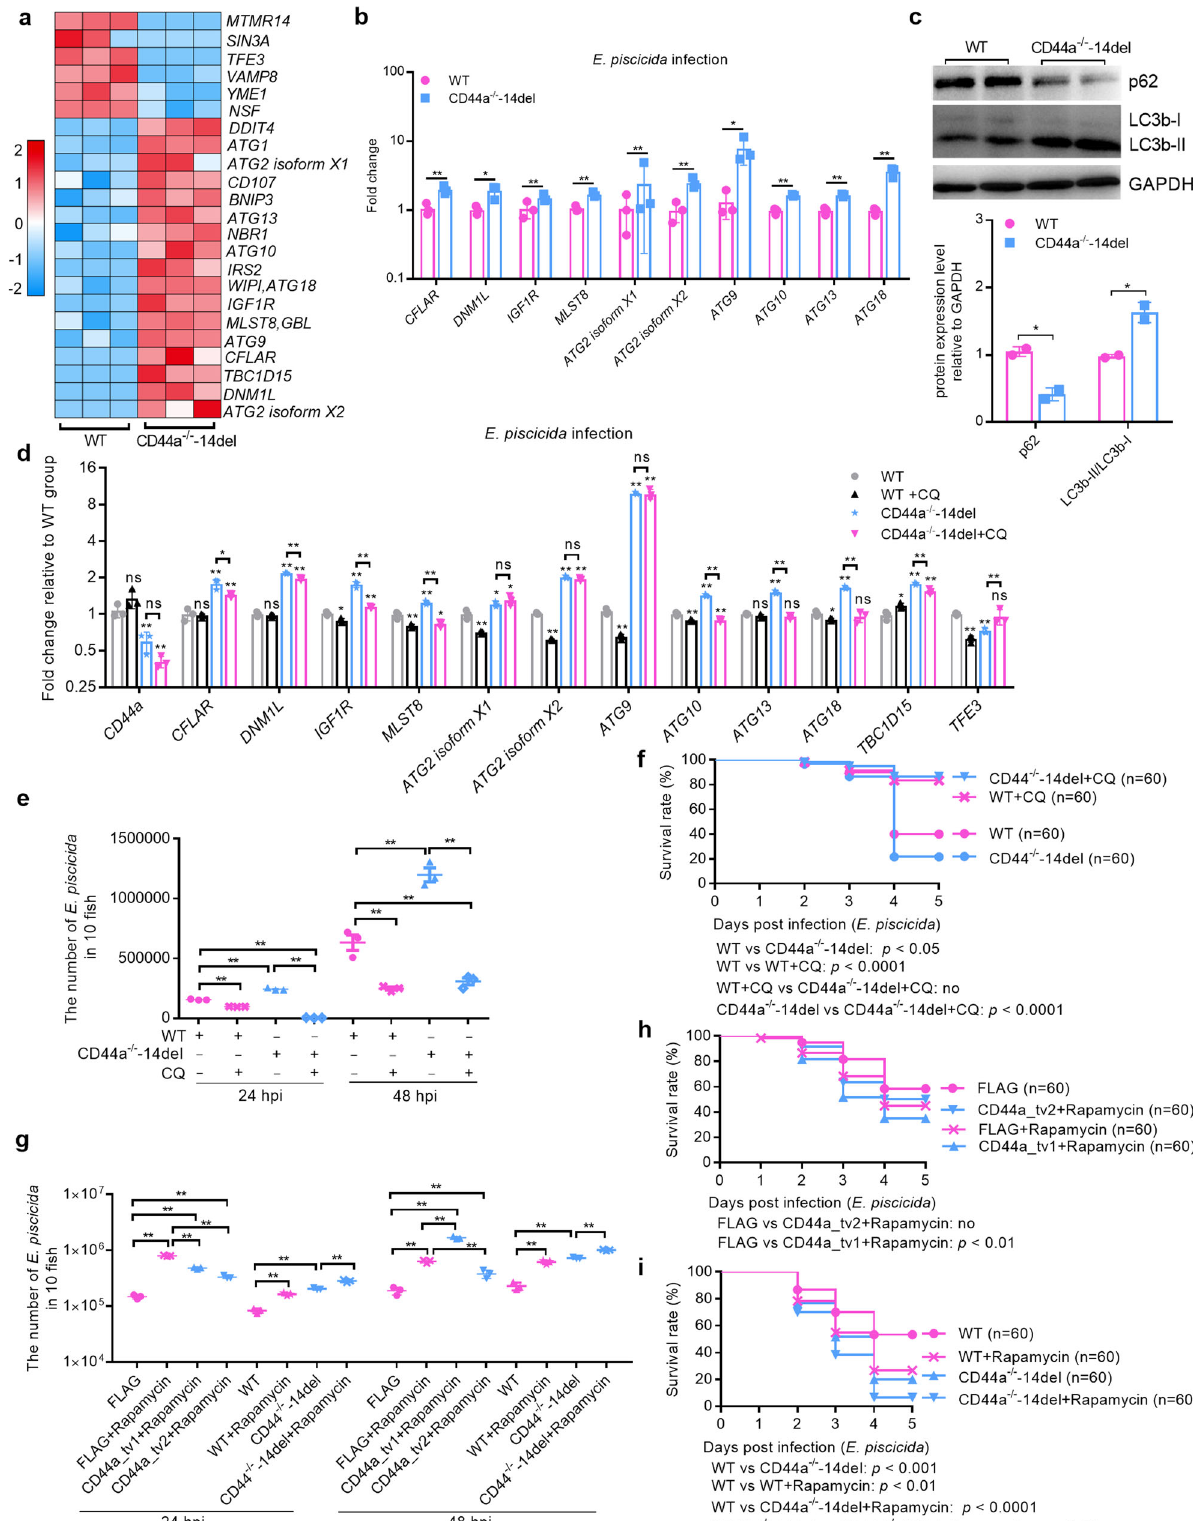
during the early developmental stage in zebra fi sh. Compared with WT zebra fi sh microinjected with FLAG empty plasmid, the overexpression of p53 had no obvious effect on the proliferative activity. However the overexpression of p53 in CD44a − / − -14del zebra fi sh embryos partially rescued the impaired proliferative activity caused by CD44a de fi ciency (Supplementary Fig. 4d,